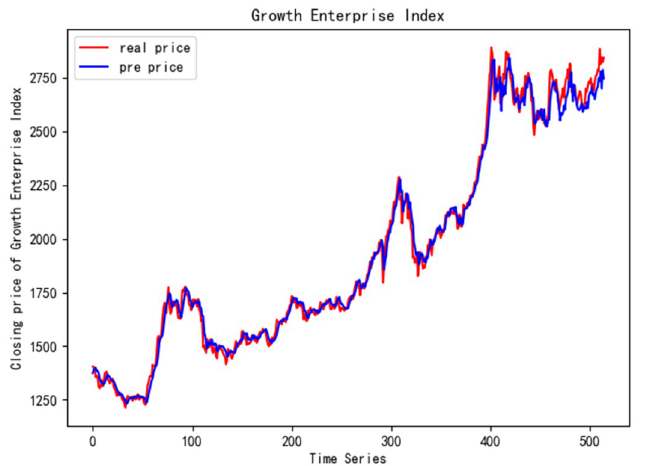
Fig 6. Closing price of Growth Enterprise